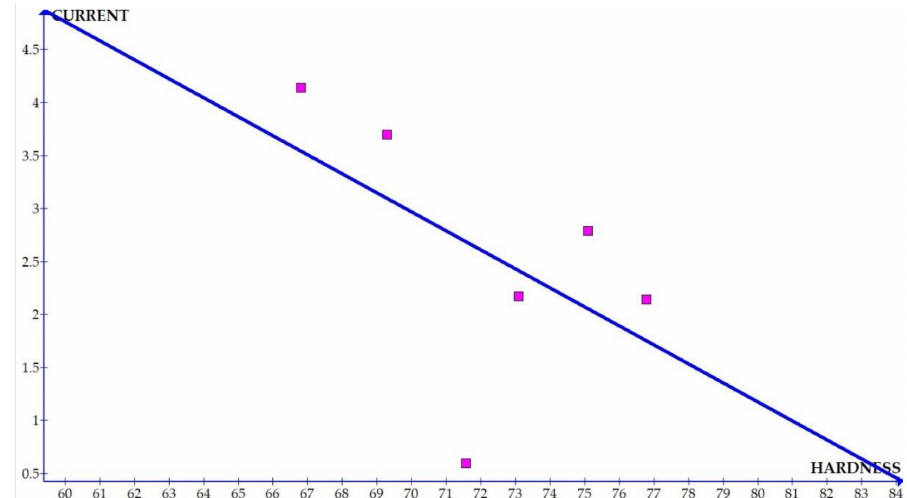
Figure 17. Coefficient of surface roughness: current vs. hardness.